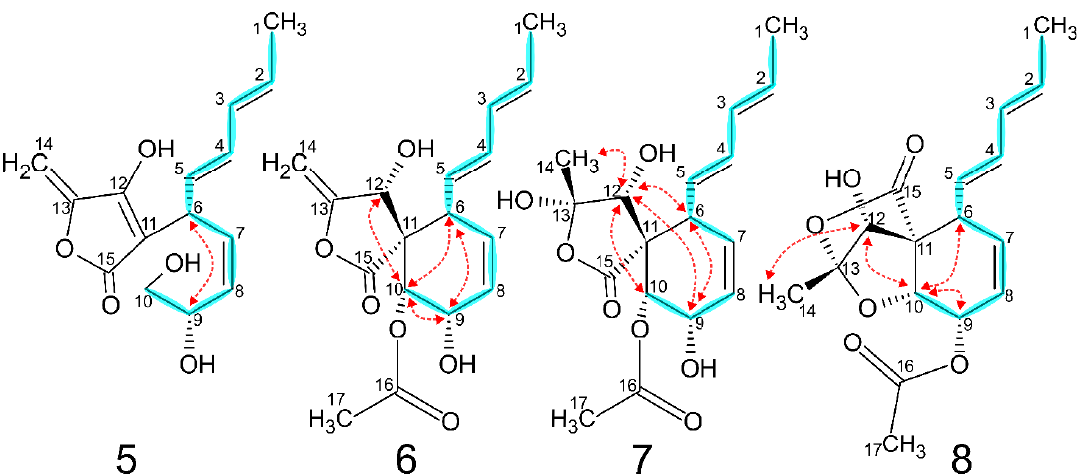
Figure 4. Diagnostic 2D NMR of 5 – 8 showing COSY (blue) and ROESY (red) correlations.